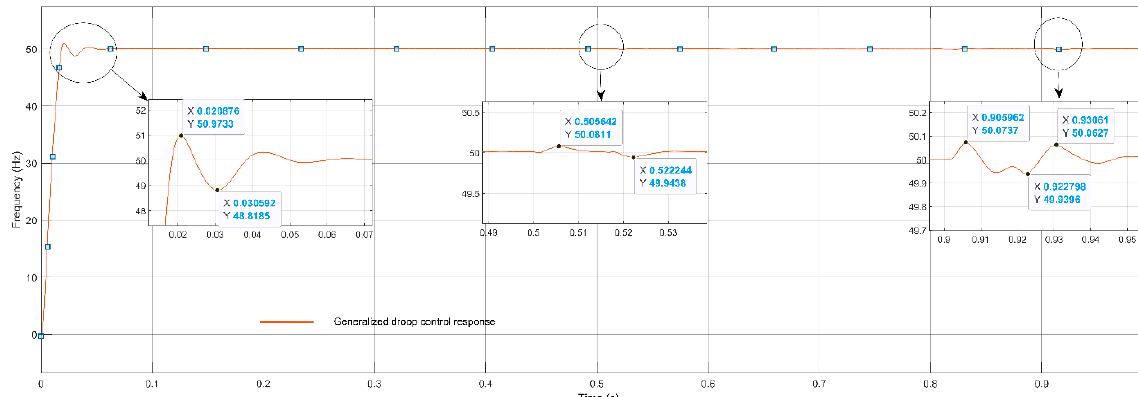
Figure 13. GDC Frequency.